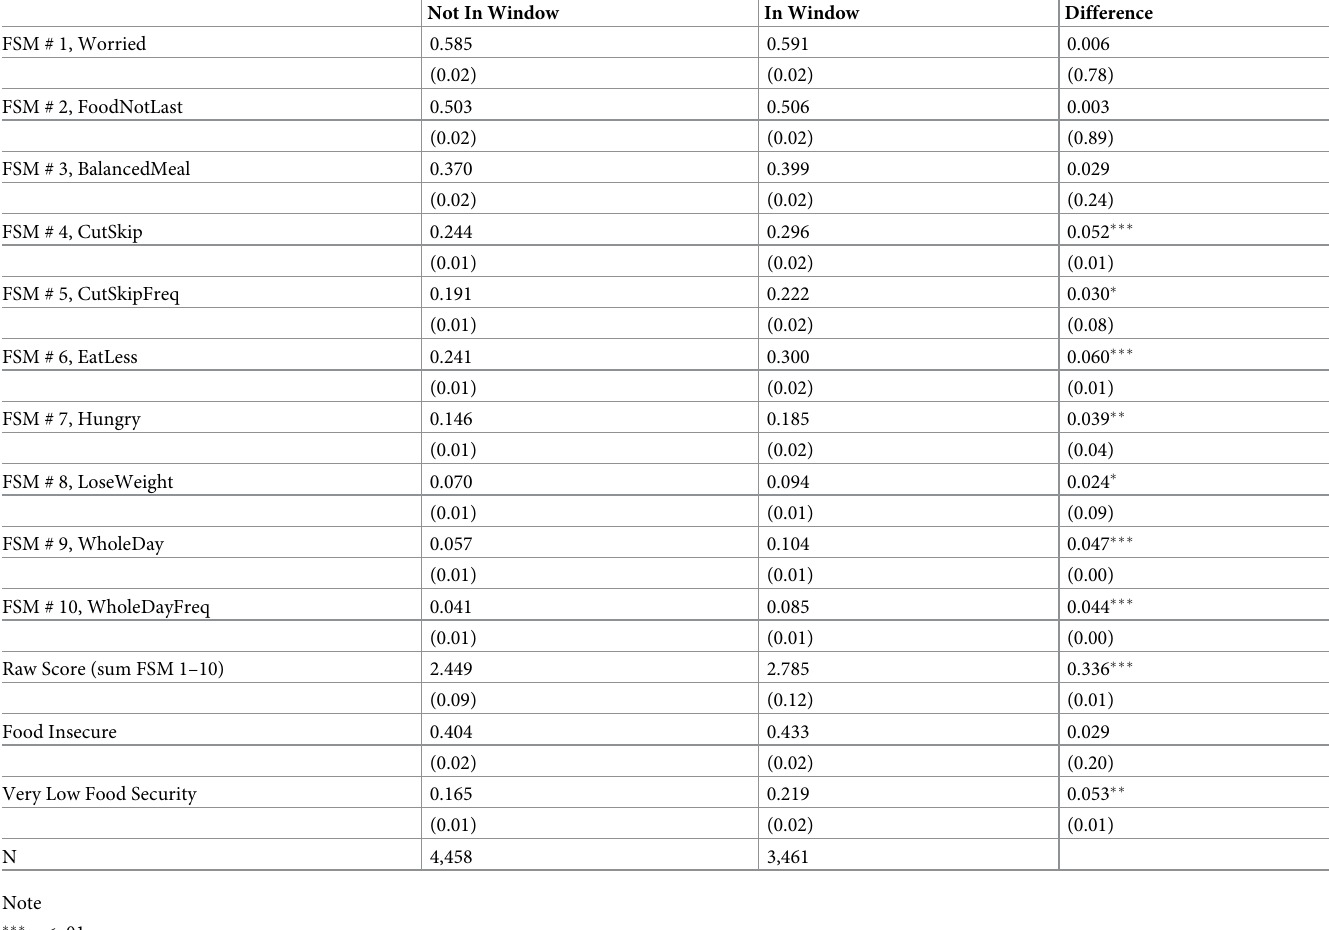
Table 2. Sample means of dependent variables.